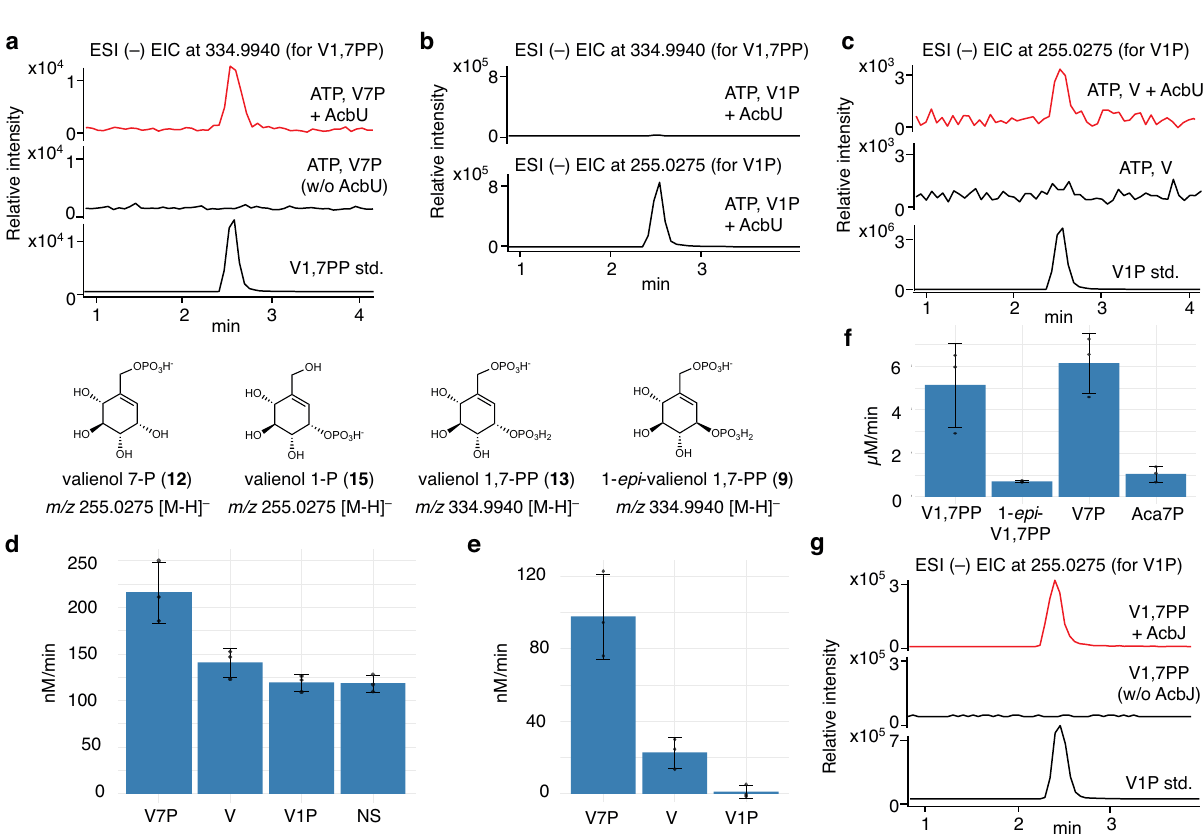
Fig. 2 Biochemical characterization of the kinase AcbU and the phosphatase AcbJ. a ESI ( – ) EIC ( m/z 334.9940) of AcbU reaction with V7P; b ESI ( – ) EIC ( m/z 334.9940 and 255.0275) of AcbU reaction with V1P; c ESI ( – ) EIC ( m/z 255.0275) of AcbU reaction with V; d PK/LDH coupled enzyme assay of AcbU reactions with V7P, V, or V1P as substrates, and no substrate (NS) in the presence of ATP. Reaction with boiled AcbU was used as a blank; e PK/ LDH coupled enzyme assay of AcbU reactions with V7P, V, or V1P as substrates in the presence of ATP. Reactions of AcbU without substrate but with ATP were used as blanks; f MESG assay of AcbJ reaction with V1,7PP, 1- epi -V1,7PP, V7P, or Aca7P as substrates; g ESI ( – ) EIC ( m/z 255.0275) of AcbJ reactions with V1,7PP. For d – f , error bars indicate standard deviation (SD) ( n = 3 analytical replicates), and data are presented as mean values ± SD. All experiments were carried out at least three times with similar results. ESI, electrospray ionization mass spectrometry; EIC, extracted ion chromatogram; V, valienol; V1P, valienol 1-phosphate; V7P, valienol 7-phosphate; V1,7PP, valienol 1,7-diphosphate; 1- epi -V1,7PP, 1- epi -valienol 1,7-diphosphate; Aca7P, acarbose